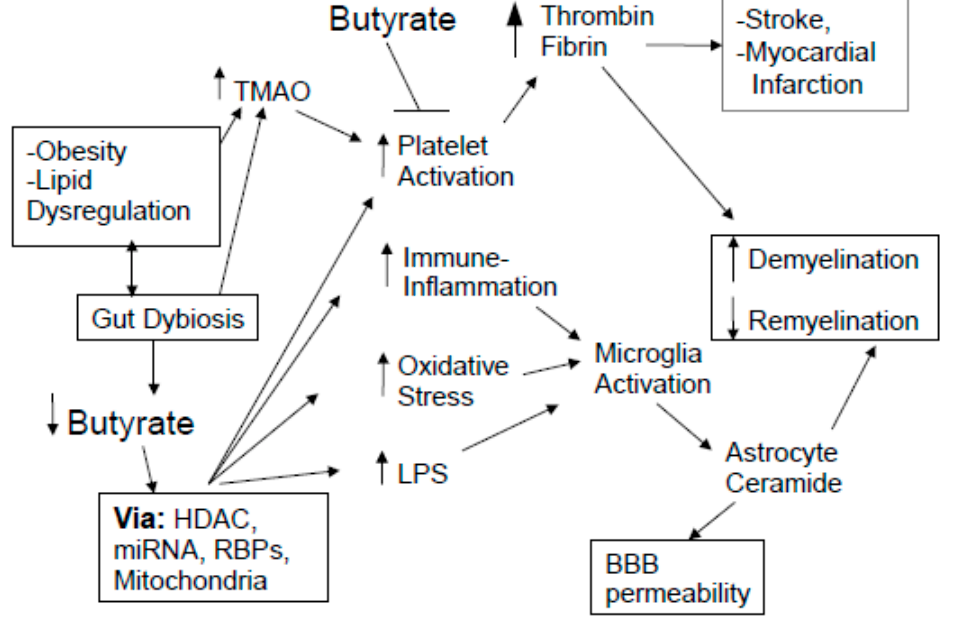
Figure 2. Gut dysbiosis and decreased butyrate contribute to increase immune-inflammation, oxidative stress, LPS, and platelet activation, which act through microglia and astrocyte ceramide, to drive demyelination and suppress remyelination, coupled with an increase in BBB permeability. The two-way interactions of obesity / lipid dysregulation with gut dysbiosis contribute to heightened levels of TMAO. Both TMAO and the consequences of decreased butyrate lead to platelet activation and thereby to an increase in central thrombin and fibrin crossing over a compromised BBB. Raised levels of thrombin / fibrin contribute to the heightened risk of stroke and myocardial infarction in MS, as well as driving demyelination and suppressing remyelination. Abbreviations: BBB: blood-brain barrier; HDAC: histone deacetylase; LPS: lipopolysaccharide; NAS: N -acetylserotonin; miRNA: microRNA; RBP; mRNA binding protein; TMAO: trimethylamine N-oxide.